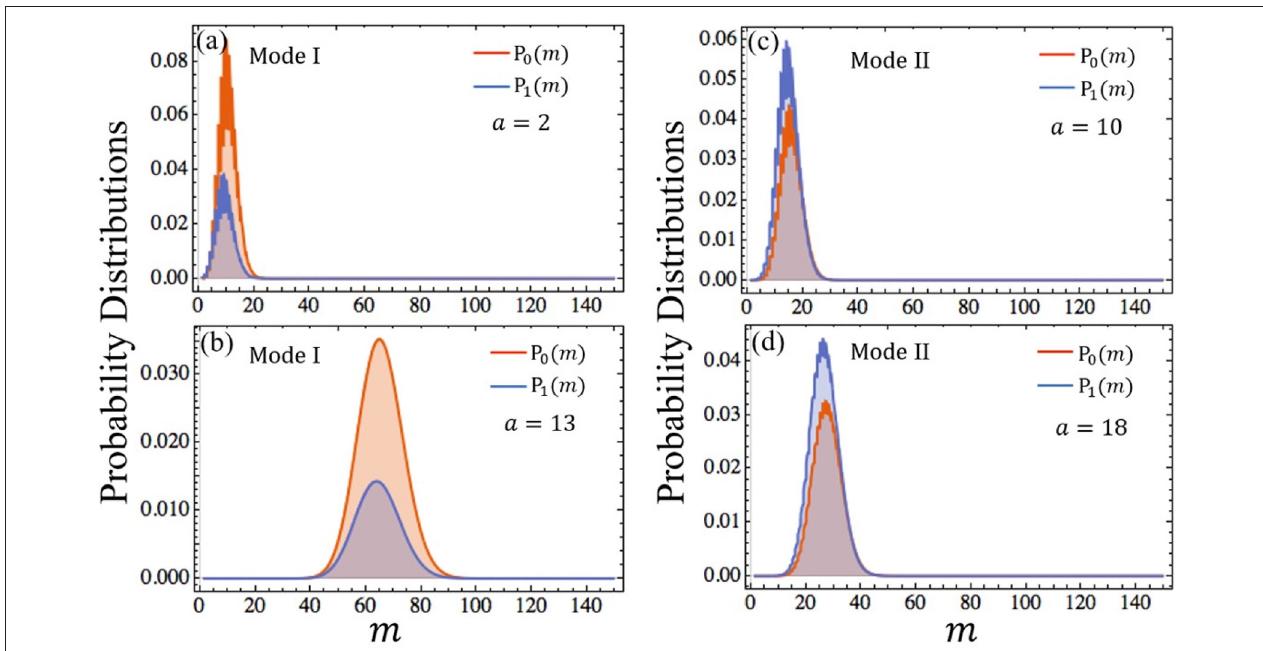
FIGURE 3 | Distributions of probability as a function of m . The synthetic rate of ROCK k 3 = 5 in (a,b) and k 3 = 1.5 in (c,d) . The value of other parameters can be found in Table S1 . P 0 ( m ) is the probability of the gene “off” state indicated with orange curve, P 1 ( m ) is the probability of gene “on” state indicated with blue curve.